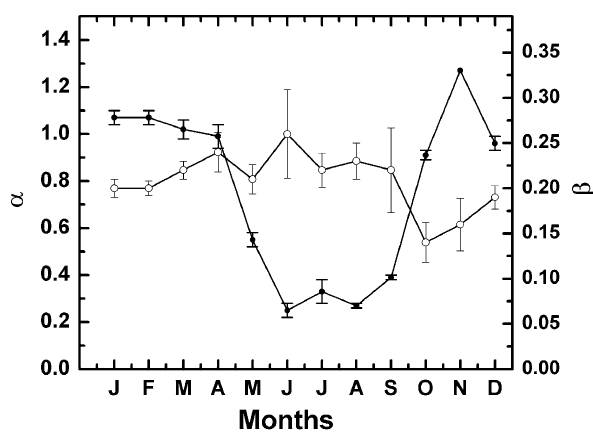
Fig. 5. The temporal variation of monthly mean values of Angstr¨om parameters ( α and β) averaged irrespective of year. The solid circles Figure 5. The temporal variation of monthly mean values of Angström parameters ( α and β ) correspond to α values and open circles correspond to β values. The averaged irrespective of year. The solid circles correspond to α values and open circles vertical lines through the points represents the standard deviation of correspond to β values. The vertical lines through the points represents the standard deviation of the the mean.